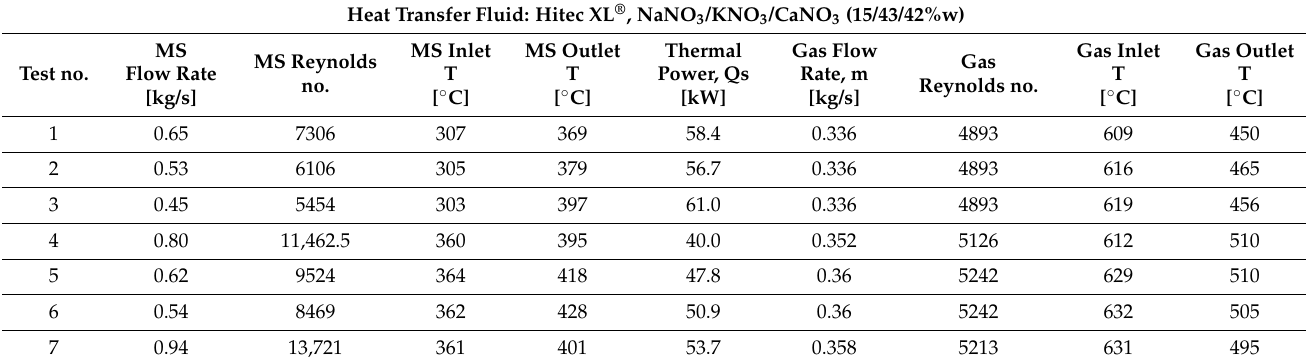
Figure 8. Effect of molten salt temperature on flow rate at constant pump speed when the ternary molten salt (Hitec XL ® ) was used. Table 3. Experimental results obtained with the MSH prototype powered with LPG and the ternary Hitec XL ® mixture as HTF.